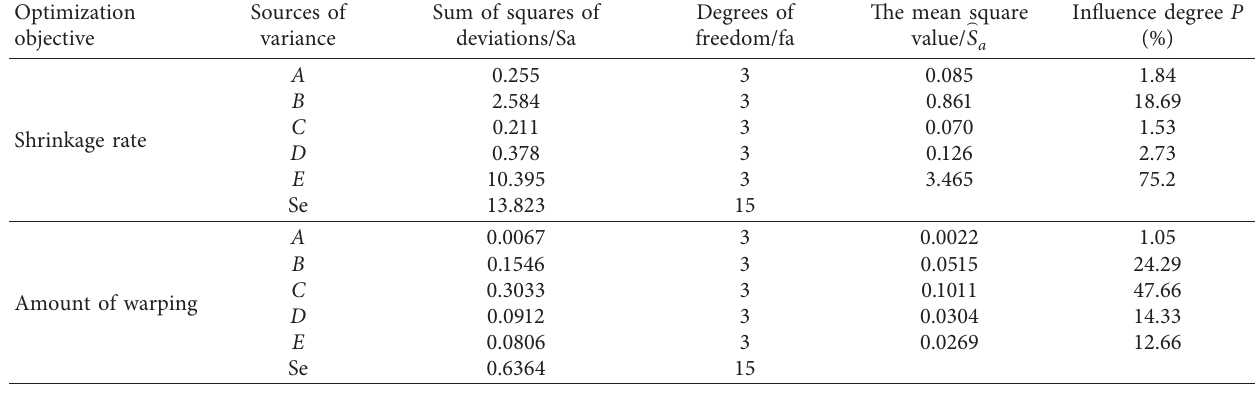
Table 6: Results of the variance analysis.